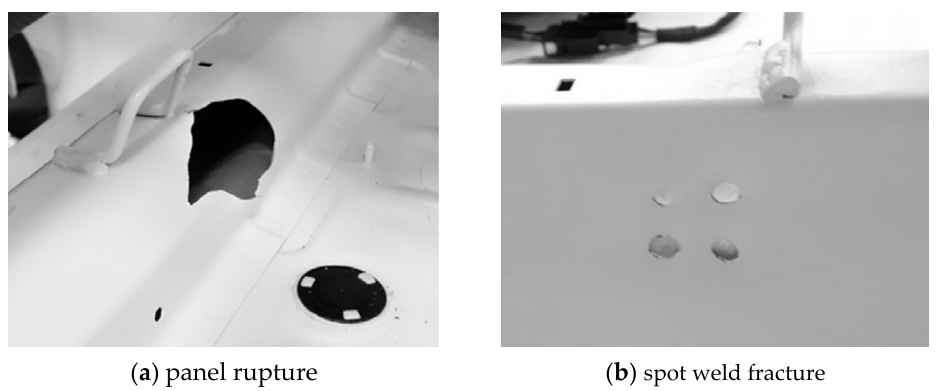
Figure 3. Failure cases of seat belt anchorage test with vehicle [6].